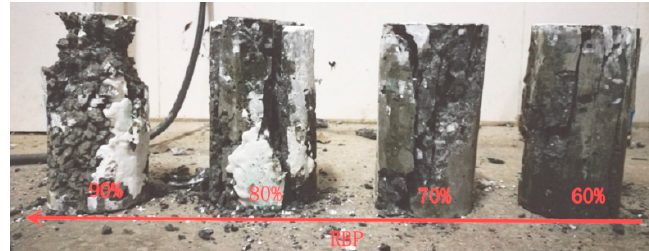
Figure 9. Failure modes of specimens with different rock contents.